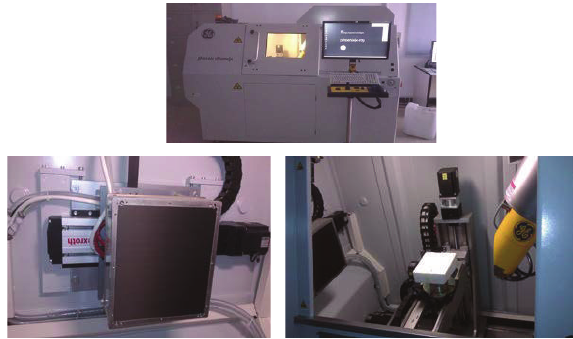
Figure 1: Photo of X-ray CT system (mode: Phoenix v | tome |